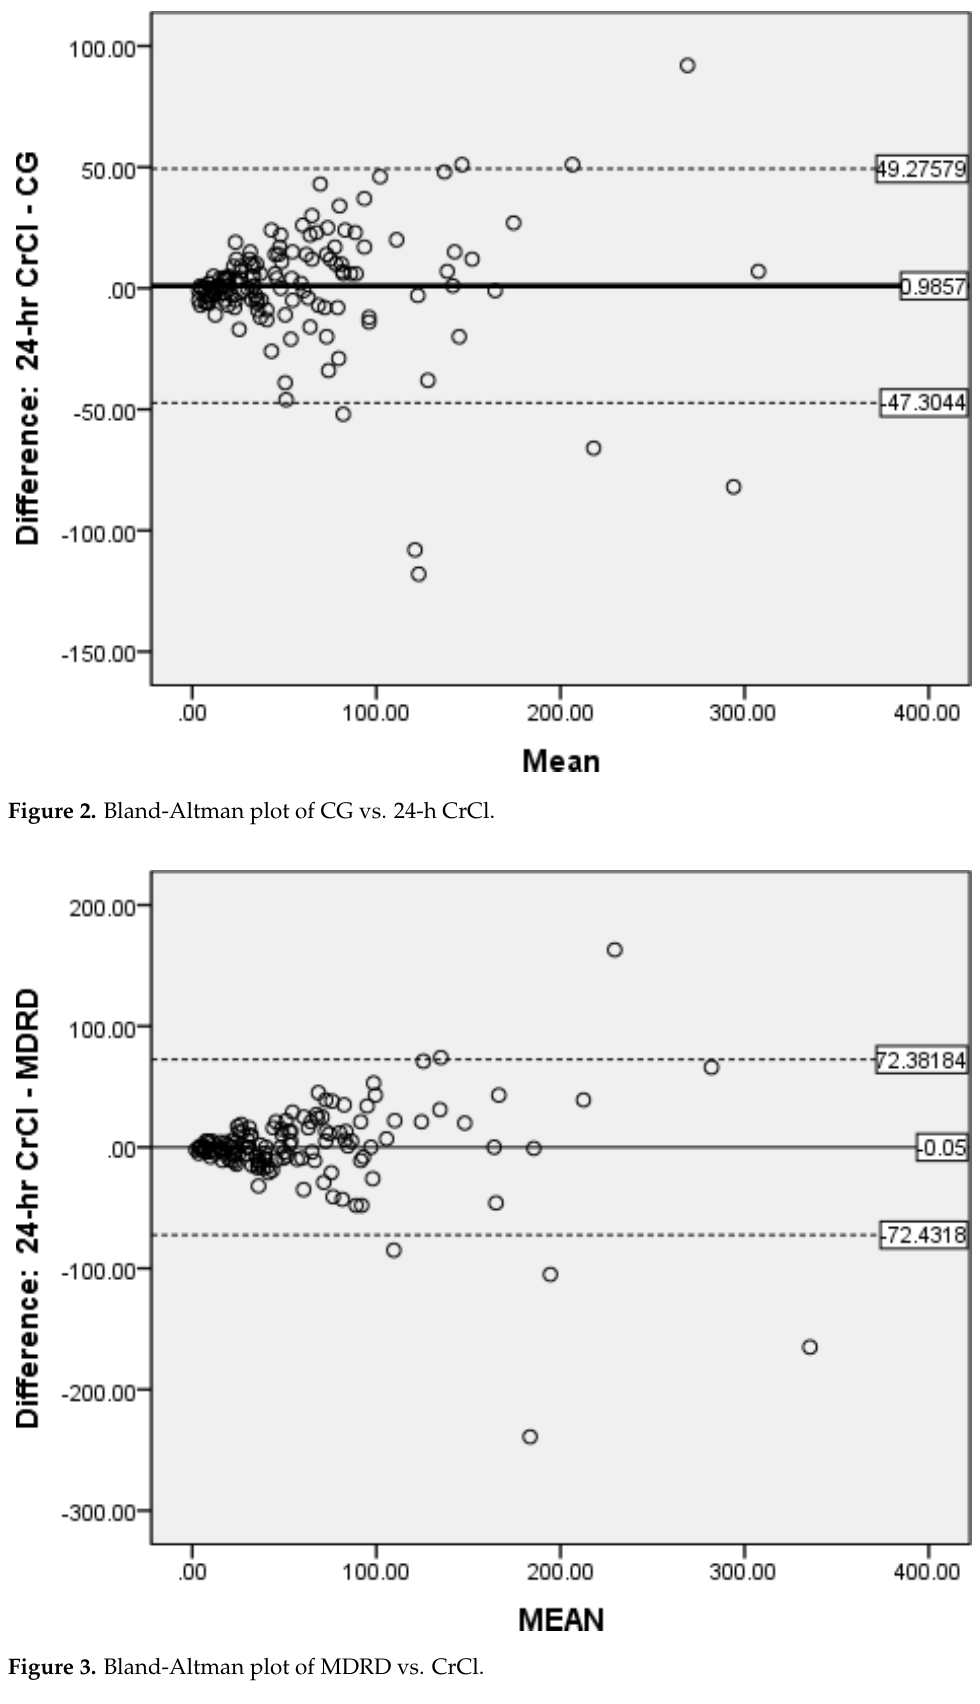
Figure 4. Bland-Altman plot of CKD-EPIcrea vs. CrCl. The MDRD had a negative bias (−0.05) with LOA of −72.4318 to 72.38184. The results for the CG and MDRD formulas were satisfactory, but unacceptable for the CKD-EPI crea